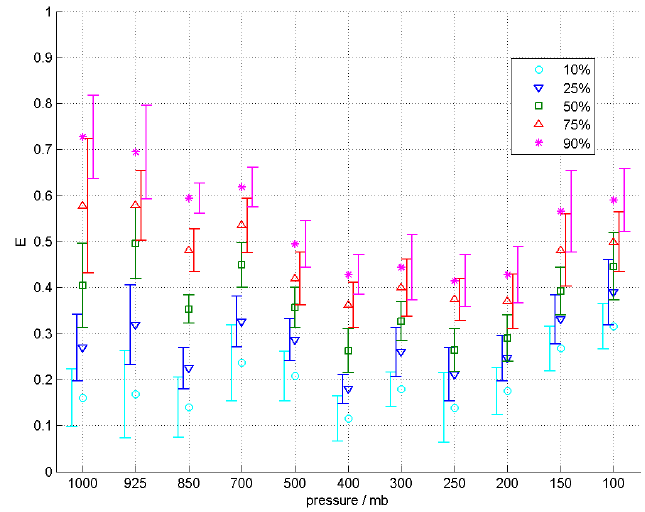
Figure 11. Results and vertical profile for the coefficient E at the five percentiles: 10%, 25%, 50%, 75%, and 90%. The error bars shown are for the 98% confidence interval.